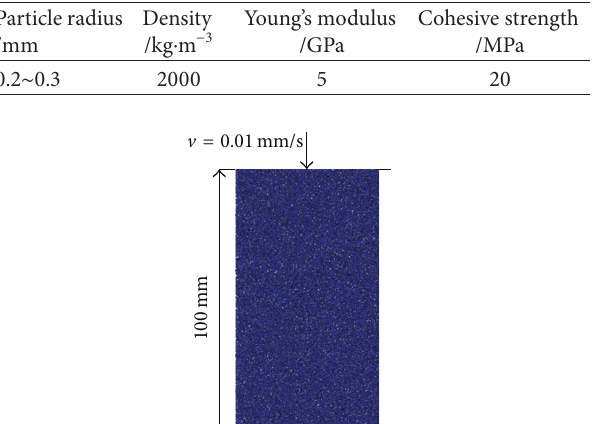
Table 1: Parameters of microstructure model.